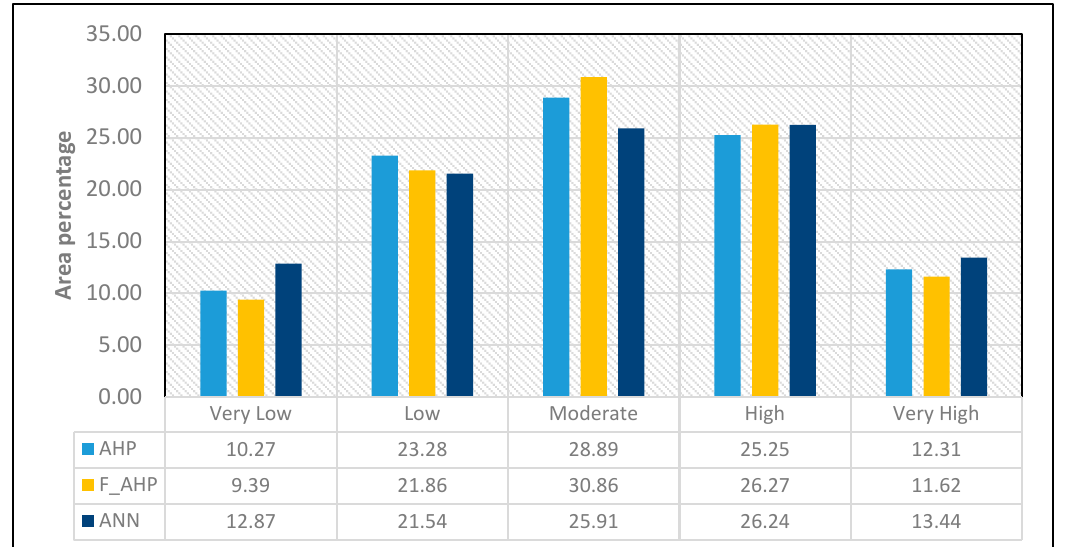
Figure 12. Graph showing distribution of area percentage of different classes.